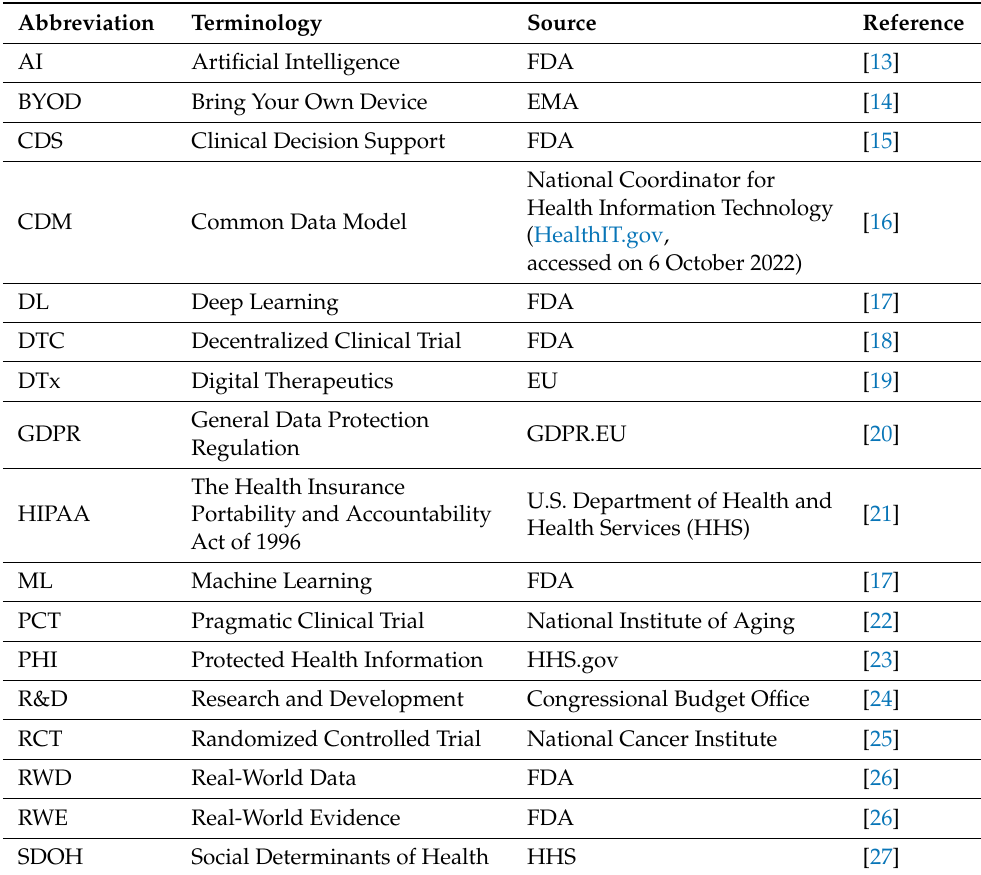
Table 1. Key abbreviations in health data analytics via AI, ML and